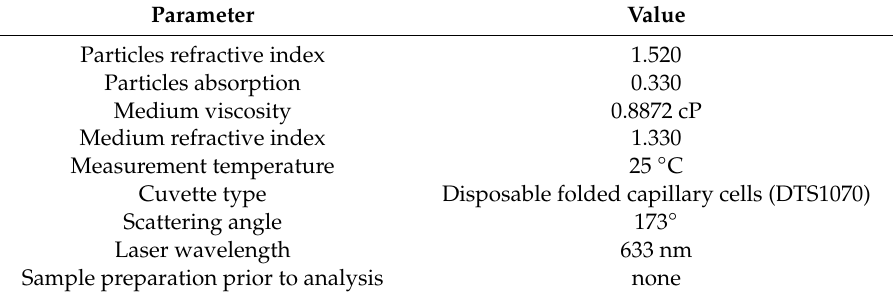
Table 1. Dynamic light scattering (DLS) conditions used for the measurement of the mean particle size (Z-ave) and polydispersity index (PdI) of